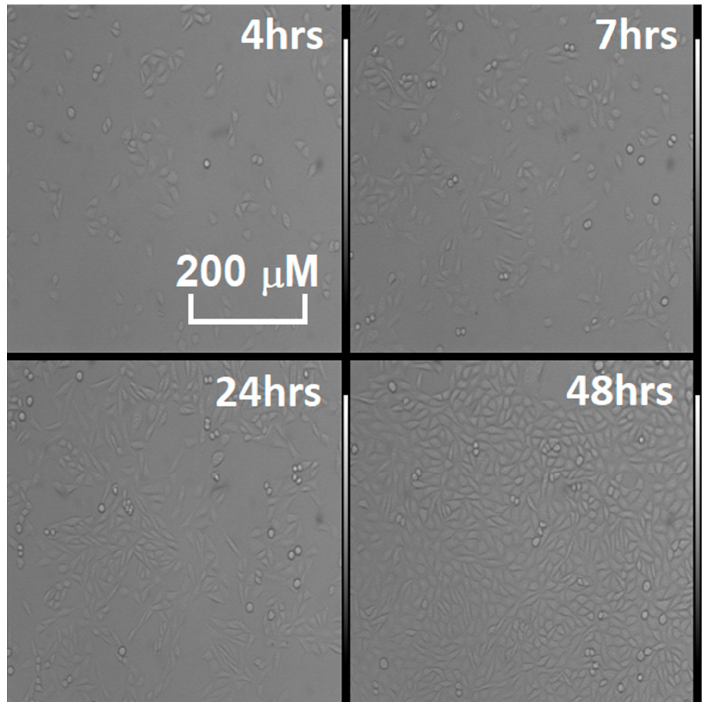
Figure 3. Time lapse of the proliferation in the various CHO cell cultures tested in Figure 2, observed through the optical microscope (model: TE 300, Nikon magnification 10X). The living, plated cells are the elongated semitransparent corpuscles, while the dead ones are the round shapes, floating in the breeding ground.